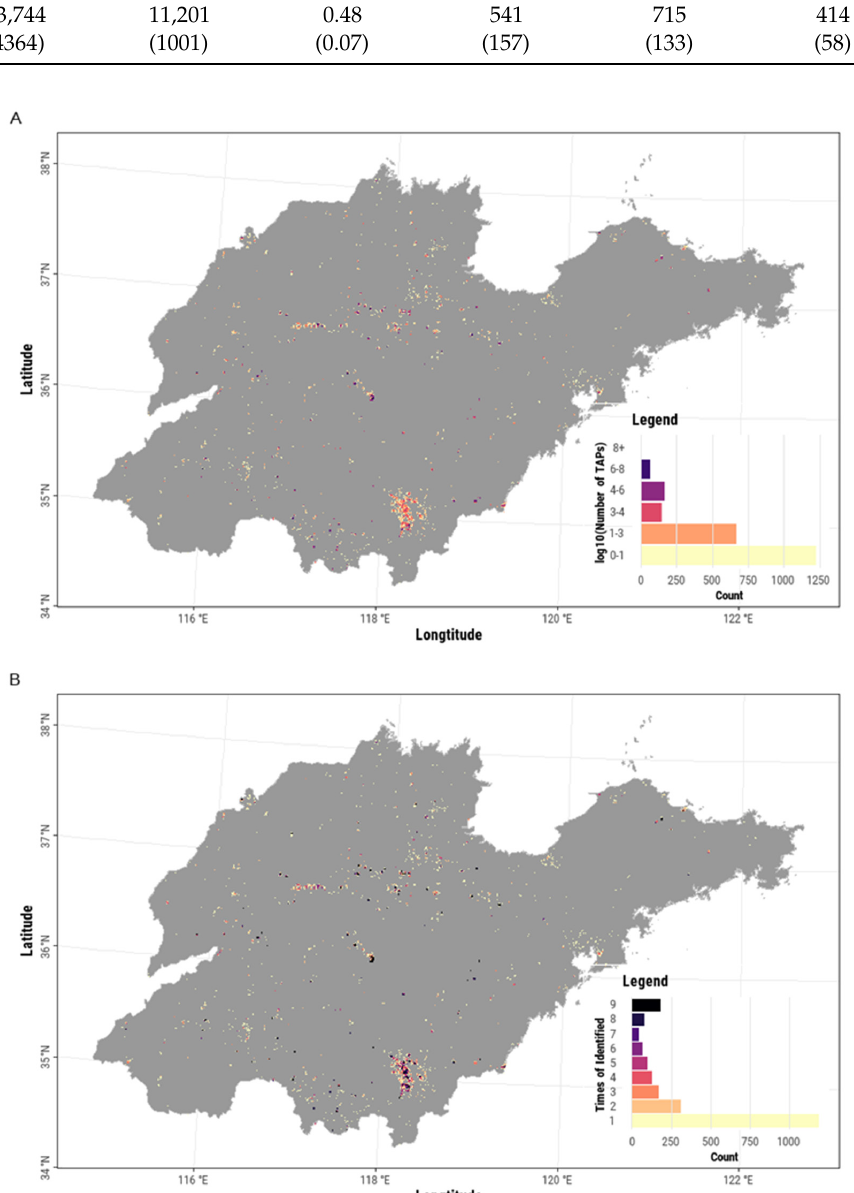
Figure 5. The spatial patterns of the thermal anomaly pixels (TAPs) within industrial heat source pixels ( A ) and the observation times ( B